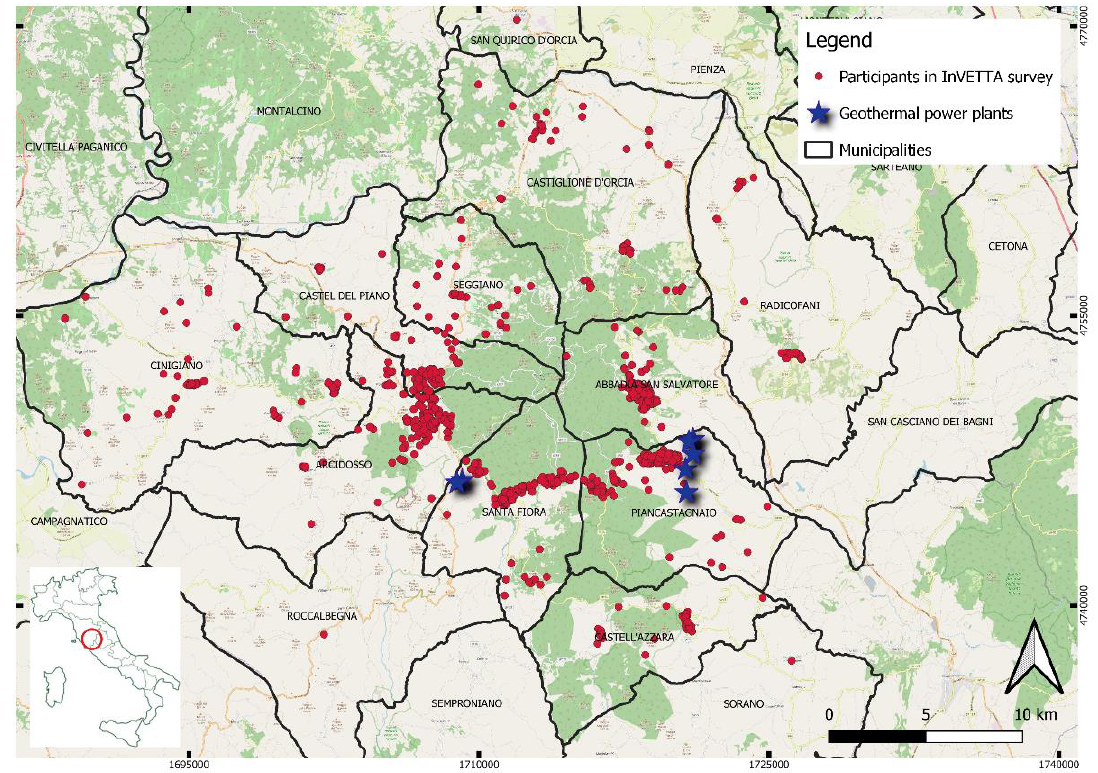
Figure 1. Localization on the territory of the 36 geothermal plants in Tuscany (blue stars) (Reference System Monte Mario/Italy Zone 1 (west time) – Datum: Roma40 – Projection: Gauss-Boaga – west time – EPSG 3003). Note: For privacy reasons and to protect the confidentiality we applied geomasking techniques with a random shifting of the coordinates of the points.